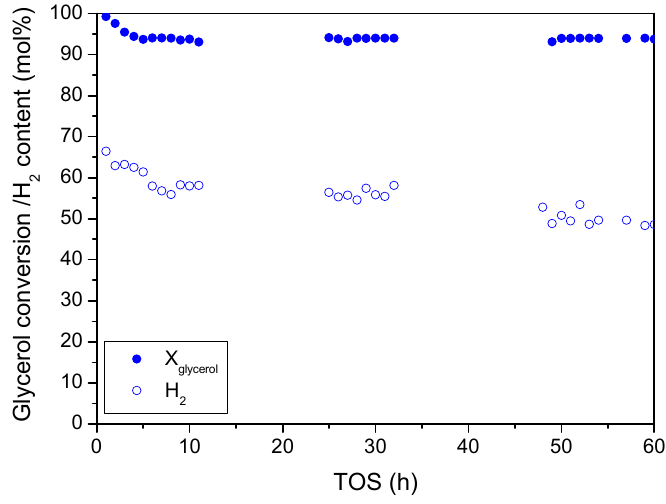
Figure 8. Evolution of glycerol conversion and hydrogen production with time-on-stream during stability test using Ni-Cr/SBA-15 catalyst ( T = 600 ◦ C, P = 1 bar, WHSV glycerol = 7.7 h − 1 ; water/glycerol = 6 mol/mol).